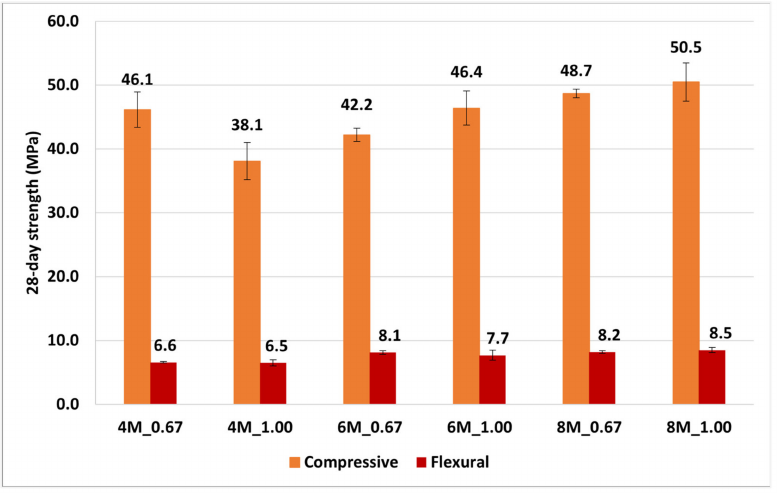
Figure 6. SS/SH ratio effect on 20%WIP at 28-day curing